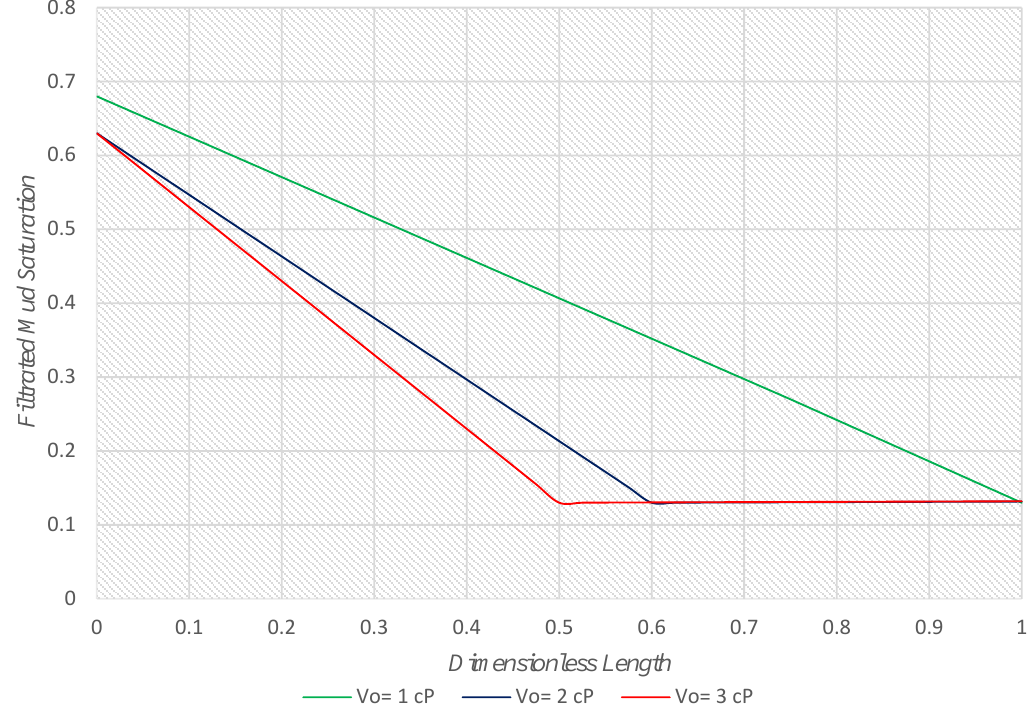
Figure 4. Oil viscosity effect on the filtrated mud saturation.